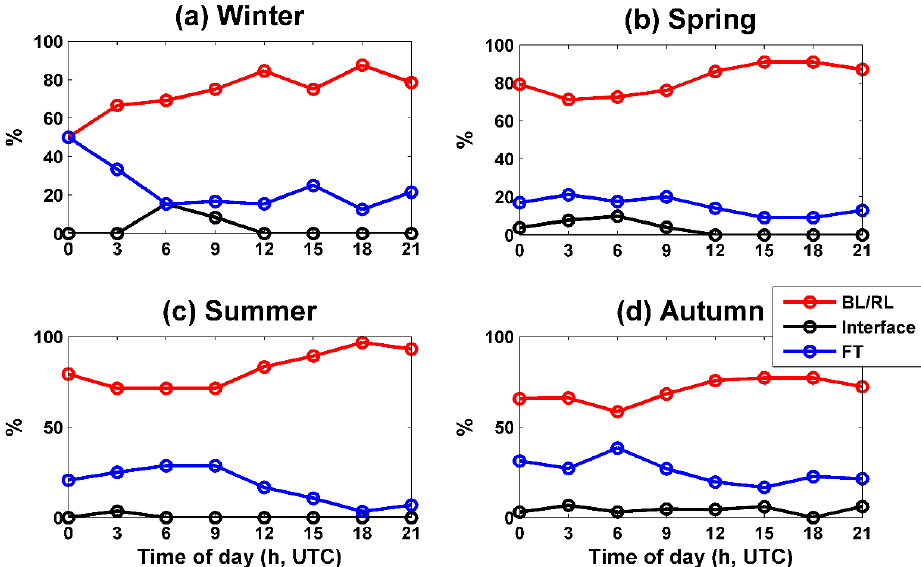
Figure 6. The diurnal variation of percentage that the PUY station is in FT/Interface/(BL/RL) conditions for the four seasons: ( a ) Winter; ( b ) Spring; ( c ) Summer; ( d ) Autumn. red : Boundary Layer (BL) (daytime)/Residual Layer (RL) (nighttime), black : Interface, blue : Free Troposphere (FT).